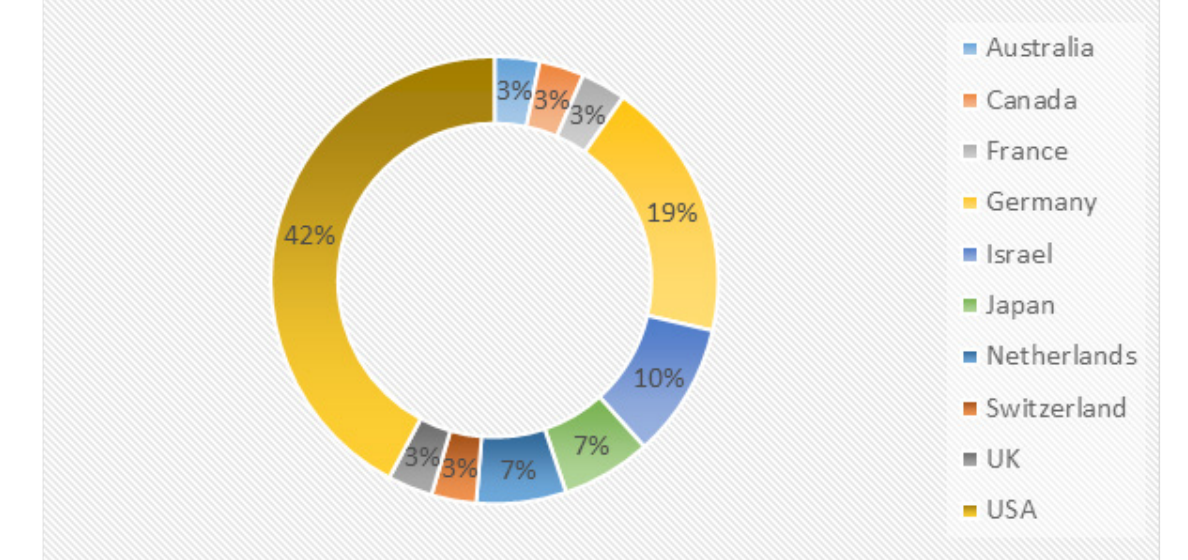
Graphical representation of the total number of Nobel Laureates (by country, %) who attended the 66th Lindau Nobel Laureate